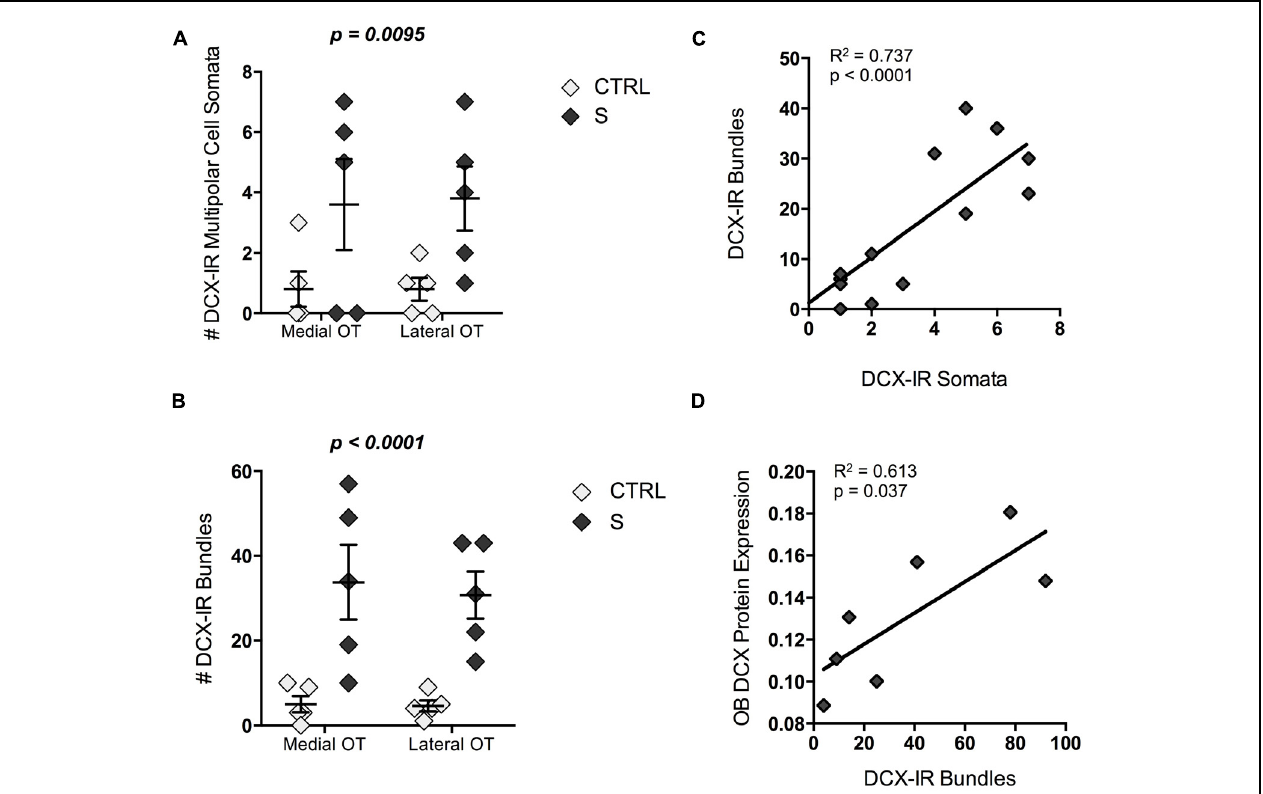
FIGURE 5 | Doublecortin-immunoreactive cells and process bundle number in the OT of individuals who died by suicide (S; n = 5) and controls (CTRLs; n = 5). (A,B) Suicides had significantly more DCX-IR multipolar cell somata ( p = 0.037) and process bundles ( p = 0.001) in the OT than did CTRLs. (C) The total number of DCX-IR somata within the entire OT